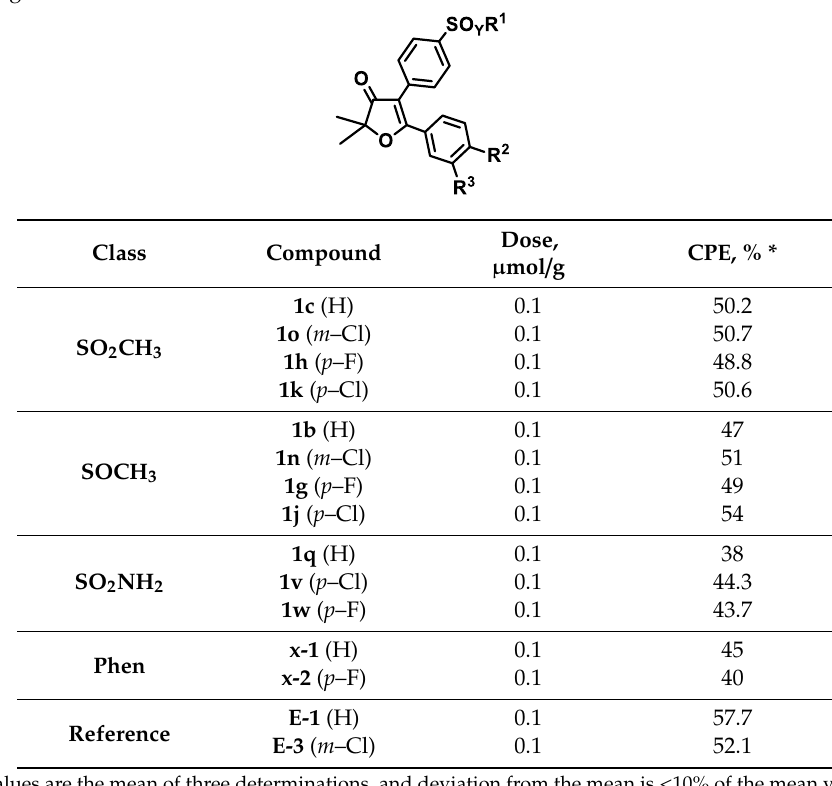
Table 7. In vivo anti-inflammatory activity of alkylsulfones and sulfoxides of furan-3( 2H )-ones, including annelated derivatives.